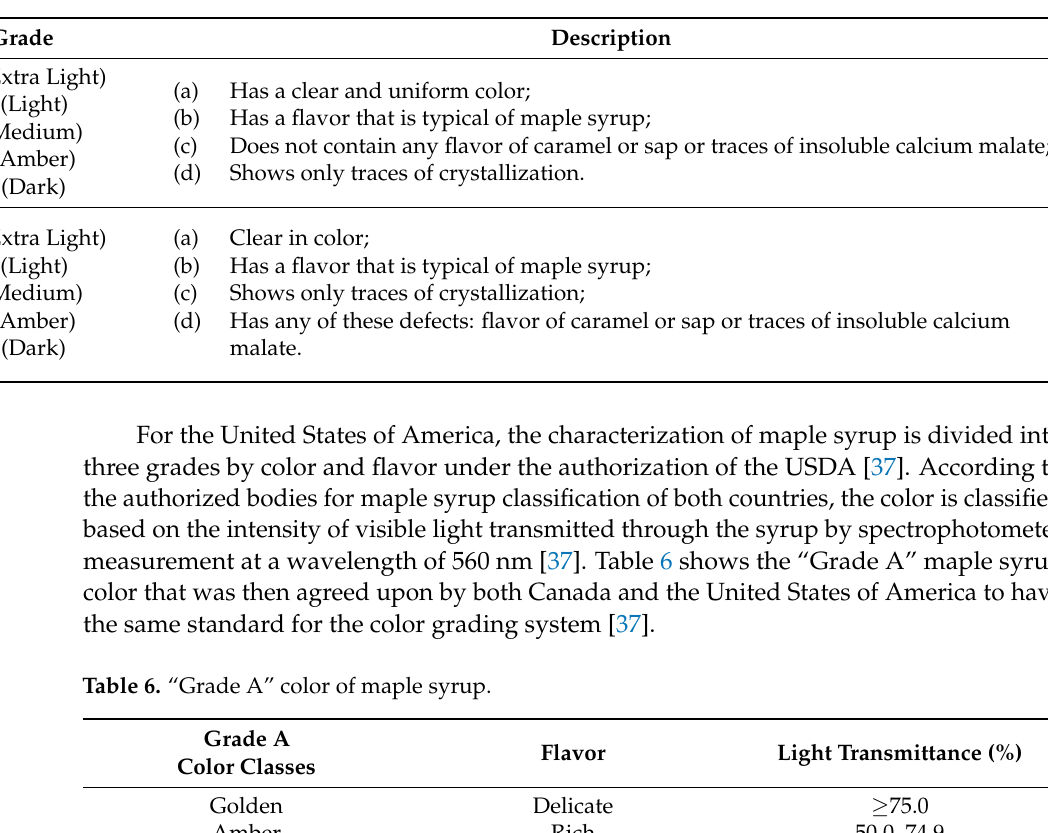
Table 5. Quebec provincial classification of maple syrup.